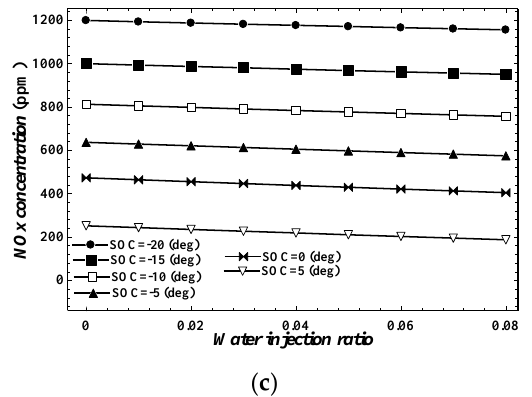
Figure 14. NOx concentration in various water injection ratios and start of combustion angles for gasoline ( a ), E5 ( b ) and E10 ( c ).